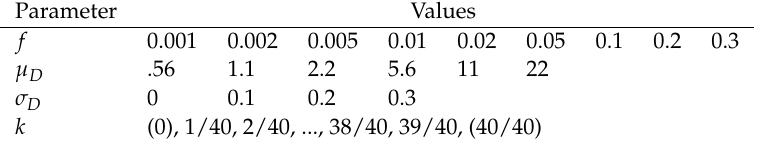
Table 3. Values for the